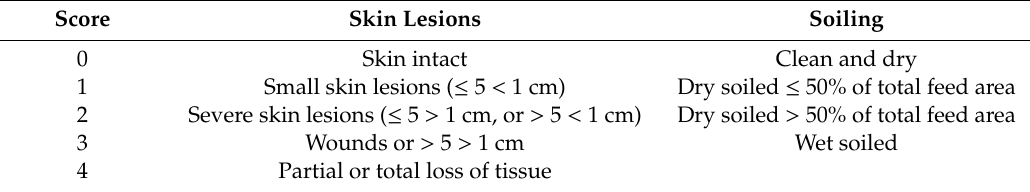
Table 1. Scoring systems to evaluate the severity of skin lesions and soiling of rabbits’ hind feet. Score Skin Lesions